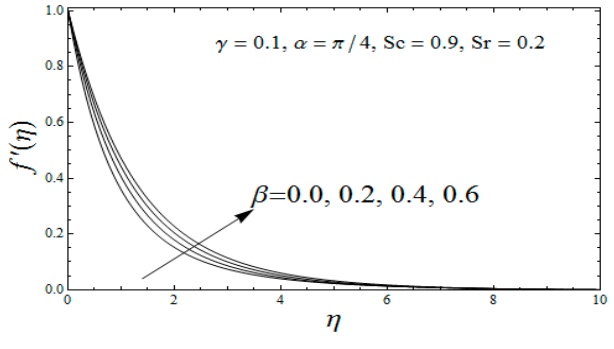
Figure 1. 𝑓′(𝜂) for different 𝛽.